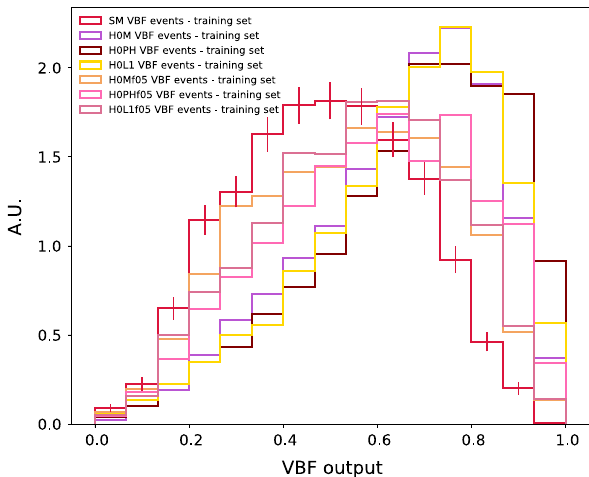
Fig. 9 Normalized distribution of the VBF-output of the DNN trained with both the SM and BSM signal events in C1. The uncertainty asso- ciated with the limited size of simulated samples is reported only in the SM distribution